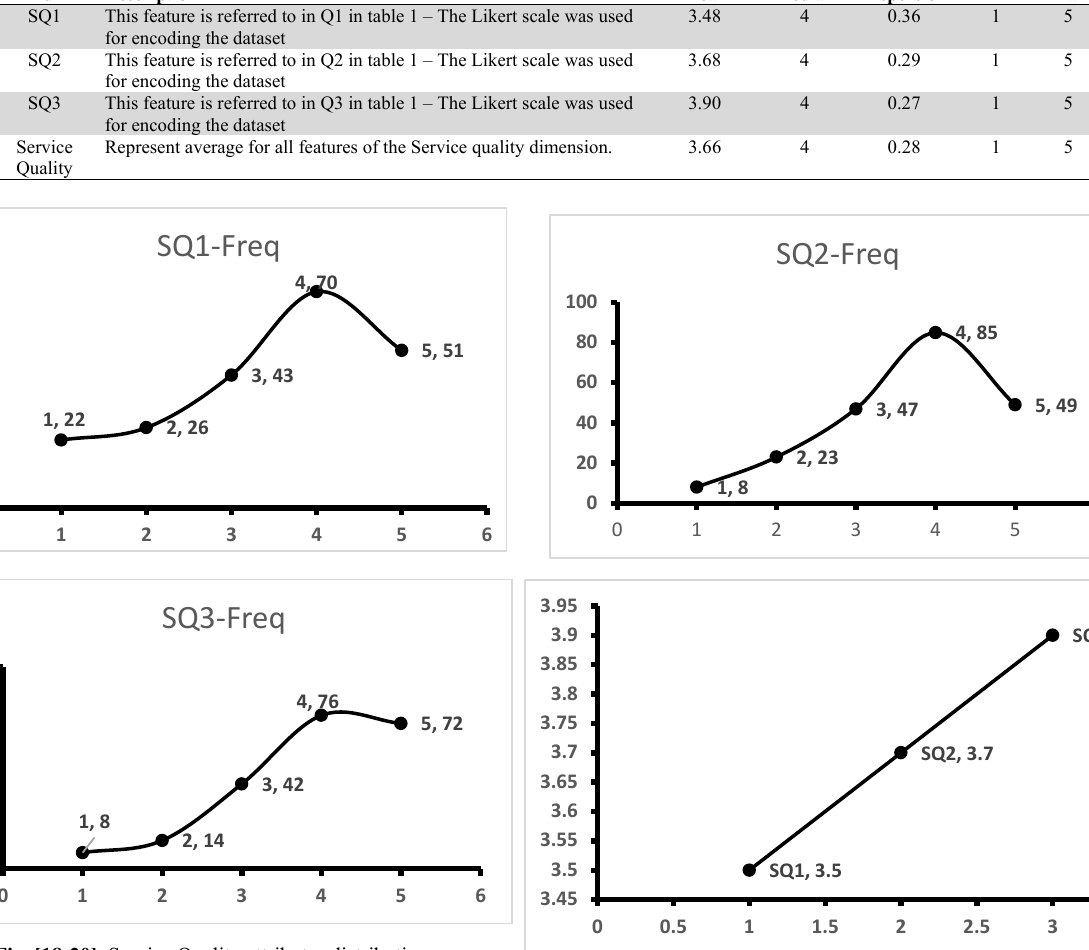
Fig. [18-20] . Service Quality attributes distributions